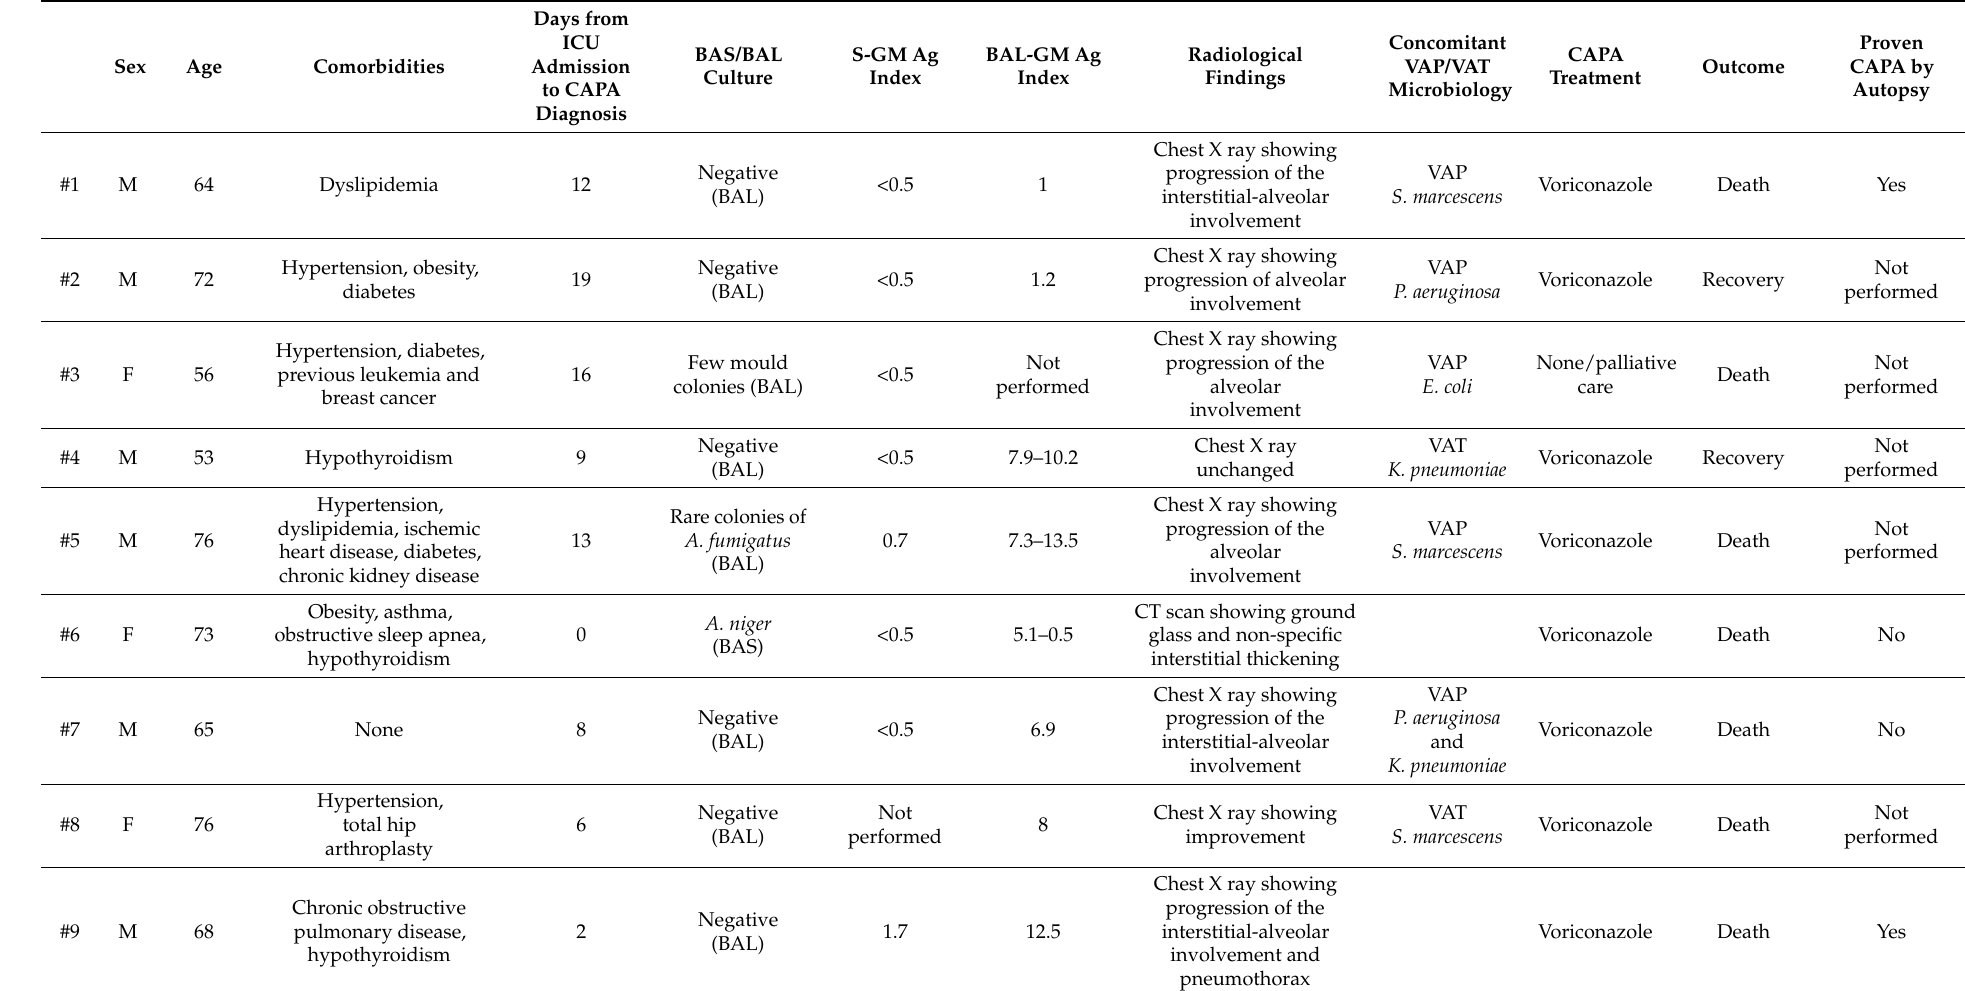
Table 2. Characteristics of patients with a CAPA